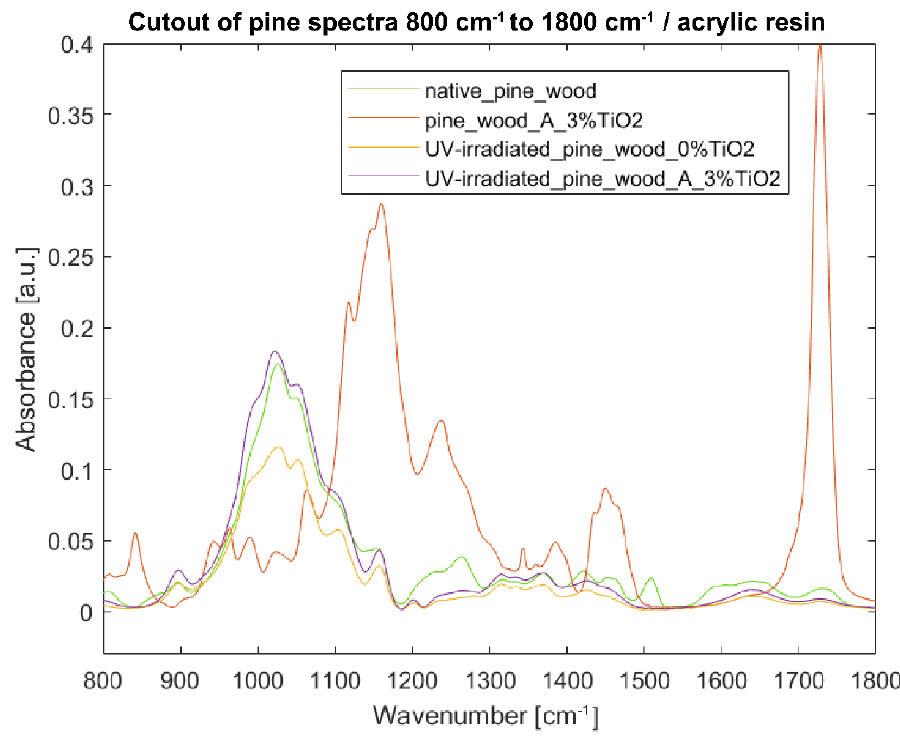
Figure 12. FTIR-ATR spectra of pine wood samples in the fingerprint region 800 – 1800 cm − 1 : (green) reference sample of native pine wood, (red) pine wood with 3% TiO 2 acrylic coating, (yellow) UV-irradiated pine wood without TiO 2 coating, and (purple) UV-irradiated pine wood with 3% TiO 2 acrylic